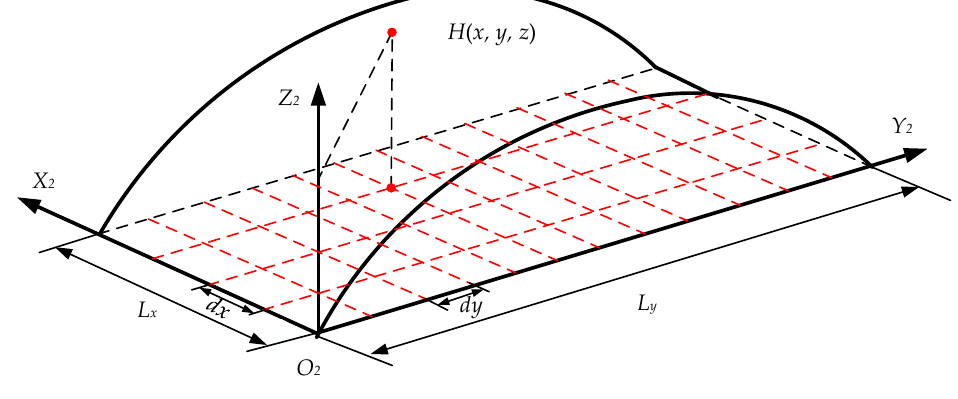
Figure 6. Discrete model of workpiece.